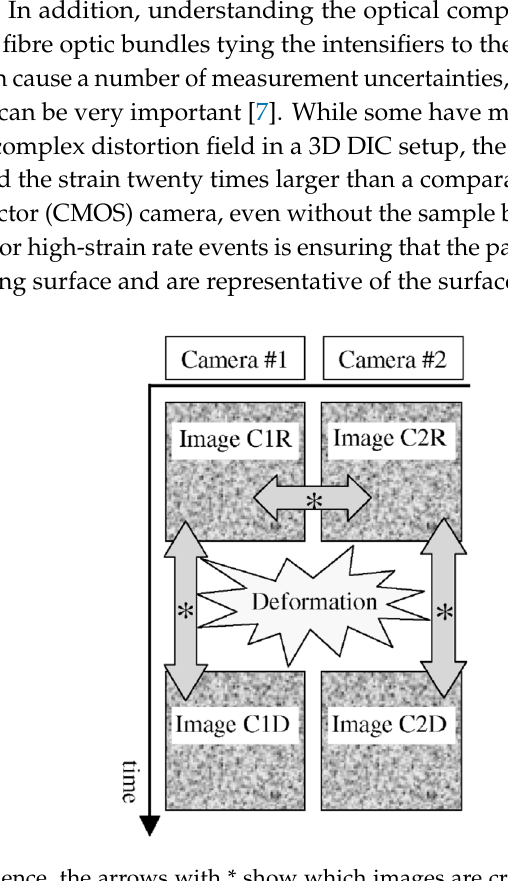
Figure 2. Time sequence, the arrows with * show which images are cross-correlated to find the 3D displacement field. Reproduced from Synnergren and Sjödahl [6], with permission from